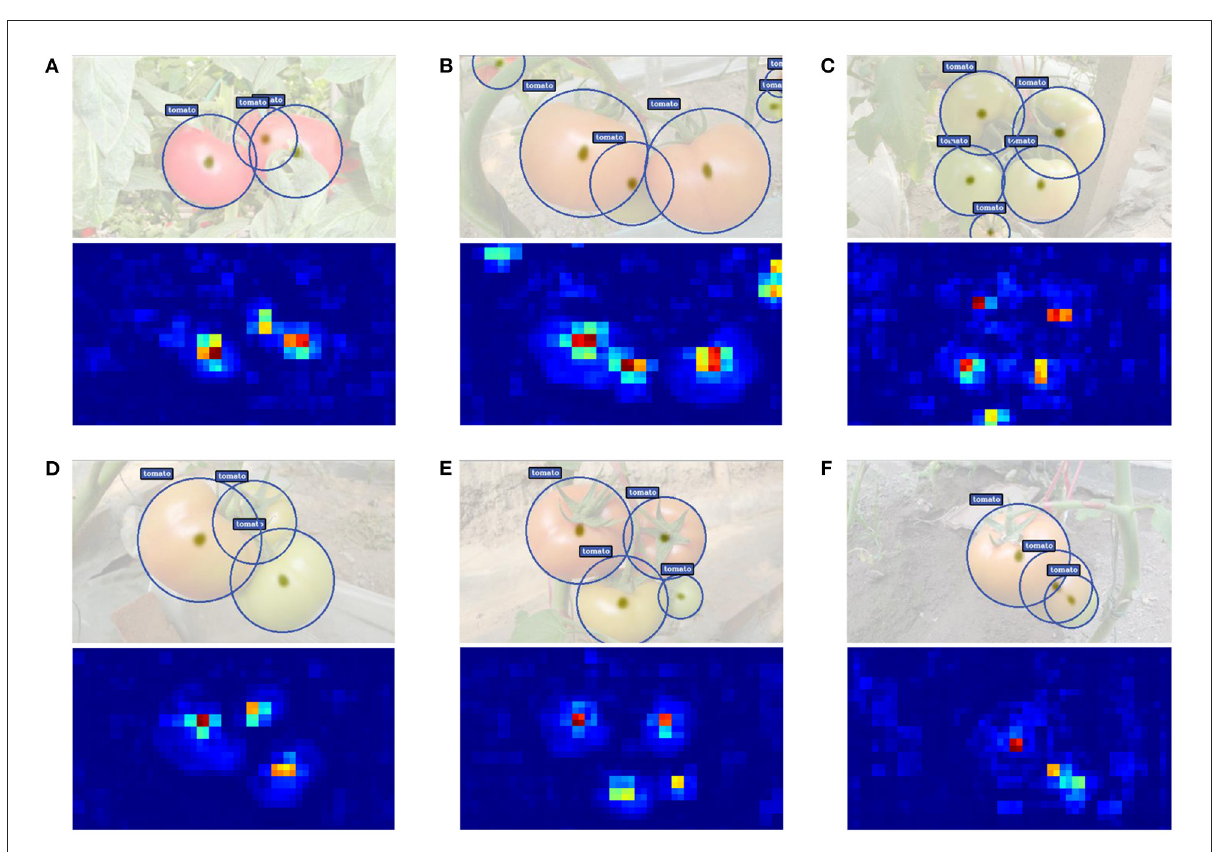
FIGURE10 (A–F) Some examples of detection results along with the output